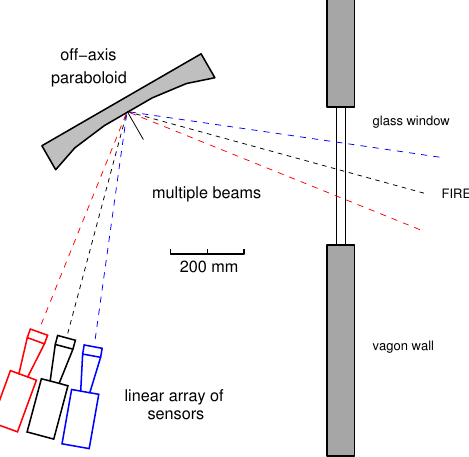
Figure 1. Concept of a multi-beam receiver with N b = 3. In this case, three independent radiometers are used for each beam. These beams are similar to the pixels of a common optical photo-camera. The secondary antennas (circular feed-horns in the figure) are mounted with a small angular offset in such a way as to produce the multiple beams. Only one main parabolic reflector is used here to the microwave radiation into each receiver.